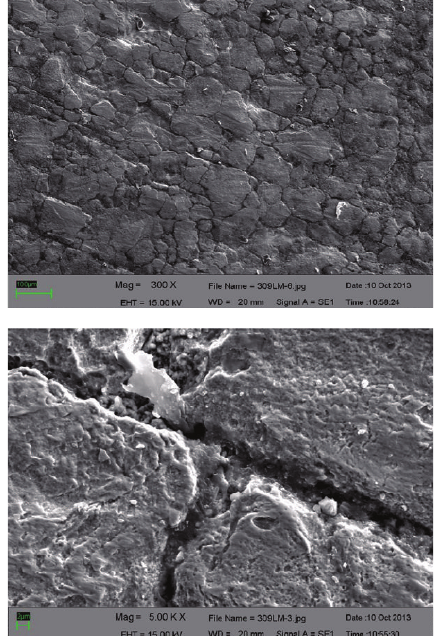
Figure 2: Micrographs of AISI-309 after five days of exposure in molten salts 50 mol% V 2 O 5 -50% Na 2 SO 4 at 700 ∘ C.